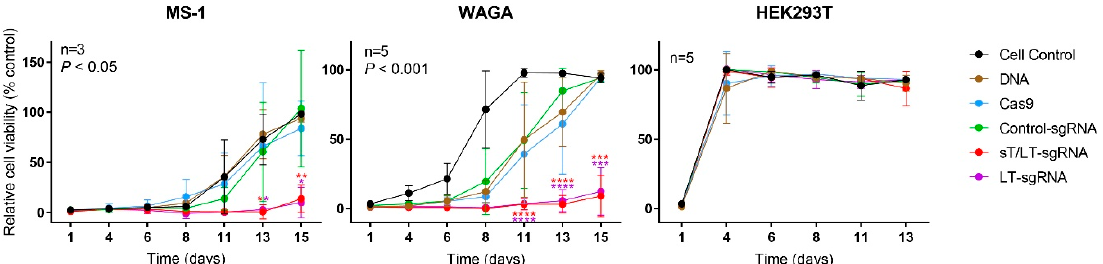
Figure 4. CRISPR/Cas9 editing of MCPyV TAs impaired cell proliferation. The day after transfection, cells were seeded in 96-well plates and growth was monitored over time using the WST-1 assay. Different control conditions were used: non-transfected cells (CC, cell control), cells transfected with an empty pUC19 plasmid (DNA), cells transfected with a plasmid expressing only Cas9 (Cas9), cells transfected with the CRISPR/Cas9 vector expressing a non-targeting sgRNA (ctr-sgRNA) and HEK293T cells transfected with all the targeting and control constructs. Cell proliferation is illustrated as a percentage relative to the cell control at 100% viability. Data are represented as mean values ± SD. The number of independent experiments is indicated (n) as well as statistical significance ( P -values) when compared with the cell control (CC).